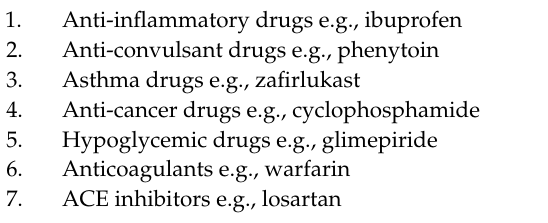
Table 2. Common CYP2C9